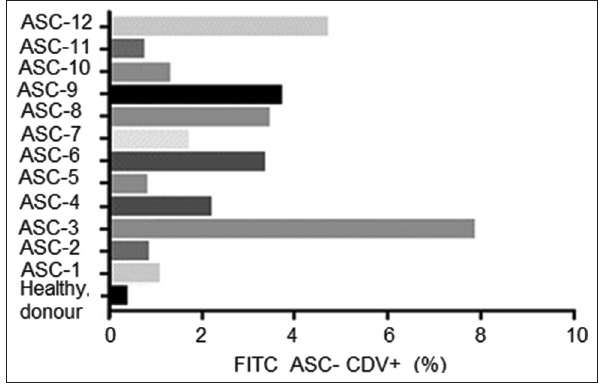
Figure-2: (a) Adipose stem cells (ASCs) infected with the vaccine canine distemper virus (40×). (b) ASCs from dogs with a natural canine distemper virus infection (100×).